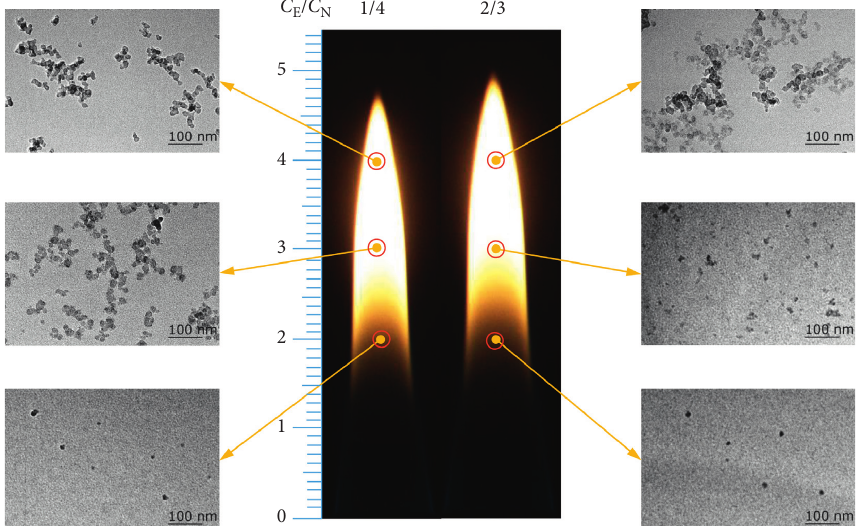
Figure 5: Comparison of soot morphology evolution of C